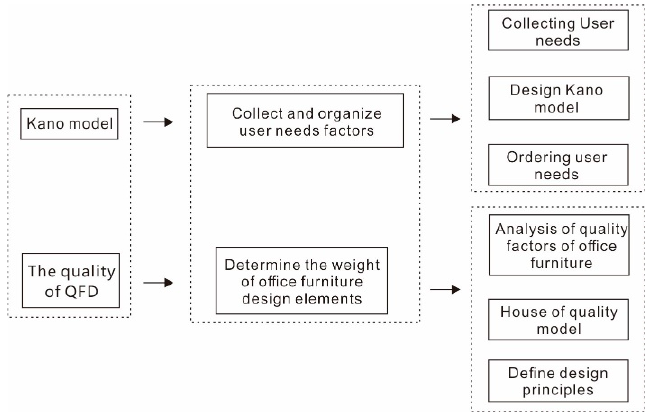
Figure 3. Kano–QFD model application process.